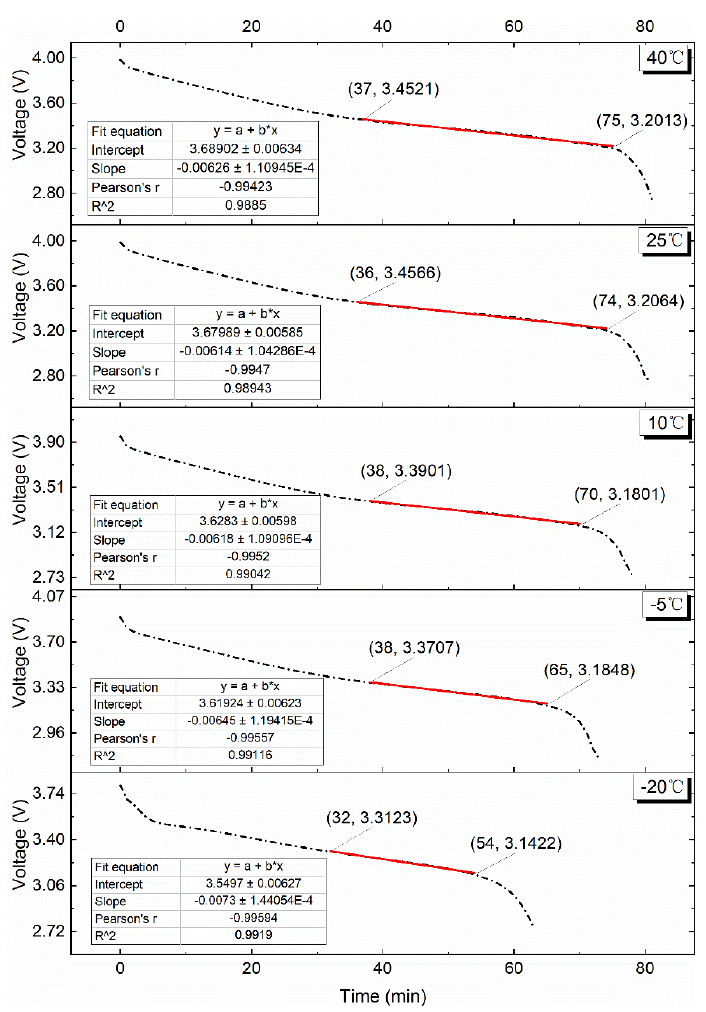
Figure 13. Influence rule of different ambient temperatures on voltage plateau period during 0.75C discharge.